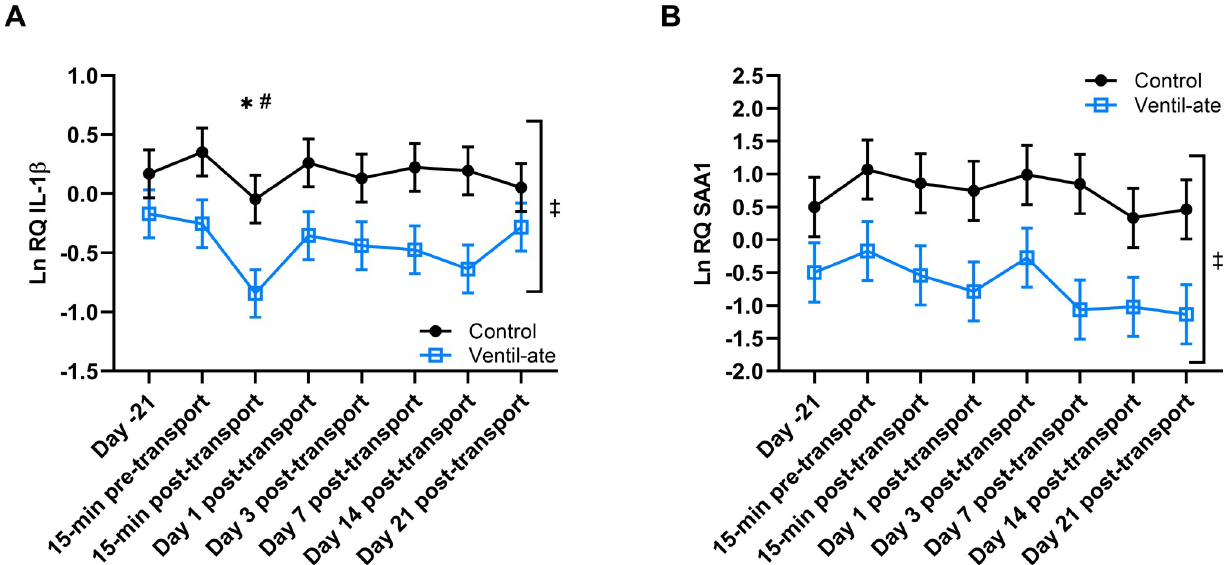
Fig 5. Expression of (A) IL-1 β and (B) SAA1 in whole blood. Relative quantities (RQ) are natural log (Ln) transformed. For illustrative purposes, the figure displays results (least squares means ± SE) from the analyses that included the group-by-time interaction; however, the significant differences shown were determined from the analyses with only group and time included as main effects. (A) Significant group ( P = 0.037) and time ( P = 0.0025) effects were observed; the group-by-time effect was not significant ( P = 0.2555). � denotes a significant difference ( P < 0.05) from baseline (Day –21). # denotes a significant difference ( P < 0.05) from all time points except Day 14 post-transport. (B) A significant group effect was detected ( P = 0.0183); the time ( P = 0.1245) and group-by-time ( P = 0.9067) effects were not significant. ‡ denotes the significant overall group difference ( P = 0.0183) between the control and supplemented groups. IL, interleukin; SAA, serum amyloid A.